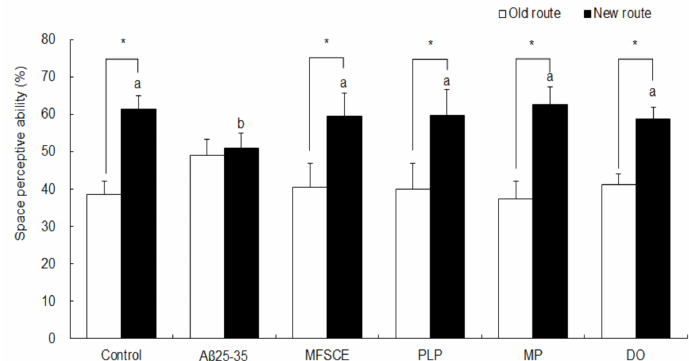
Figure 2. Effect of MFSCE on space perception ability using the T-maze test in A β 25–35 -injected mice. a,b Means with different letters are significantly different ( p < 0.05) from each group in test session. Data are expressed as mean ± SD ( n = 6). * The space perception abilities for the old and new routes are significantly different as analyzed by the Student’s t -test ( p < 0.05). Control group: 0.9%